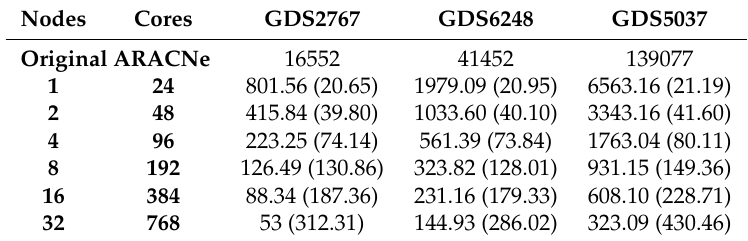
Table 1. Runtime (in seconds) and speedup of the parallel version of ARACNe using up to 32 nodes of the